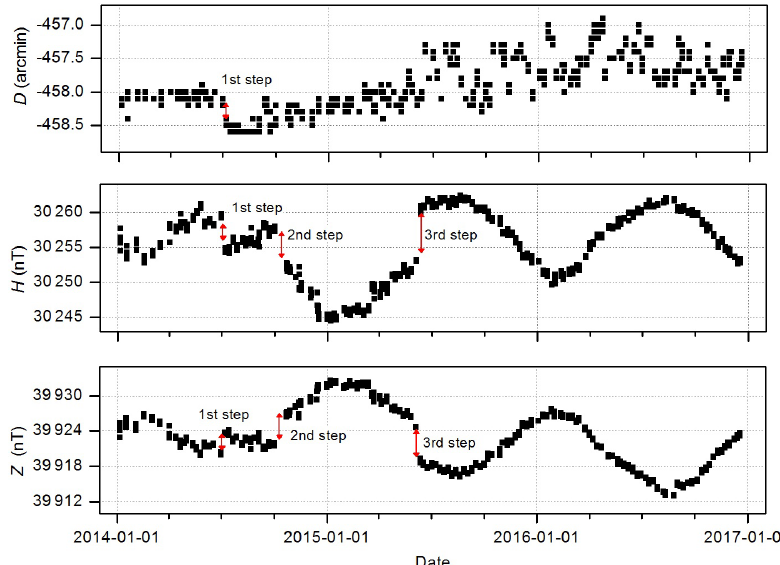
Figure 2. Observed D , H and Z baselines calculated from the measured D (declination), I (inclination) and F (total field) from 2014 to 2016. The first steps in the D , H and Z baselines occurred on 7 July 2014; the second and third steps were found in H and Z on 23 October 2014 and 12 June 2015, respectively.